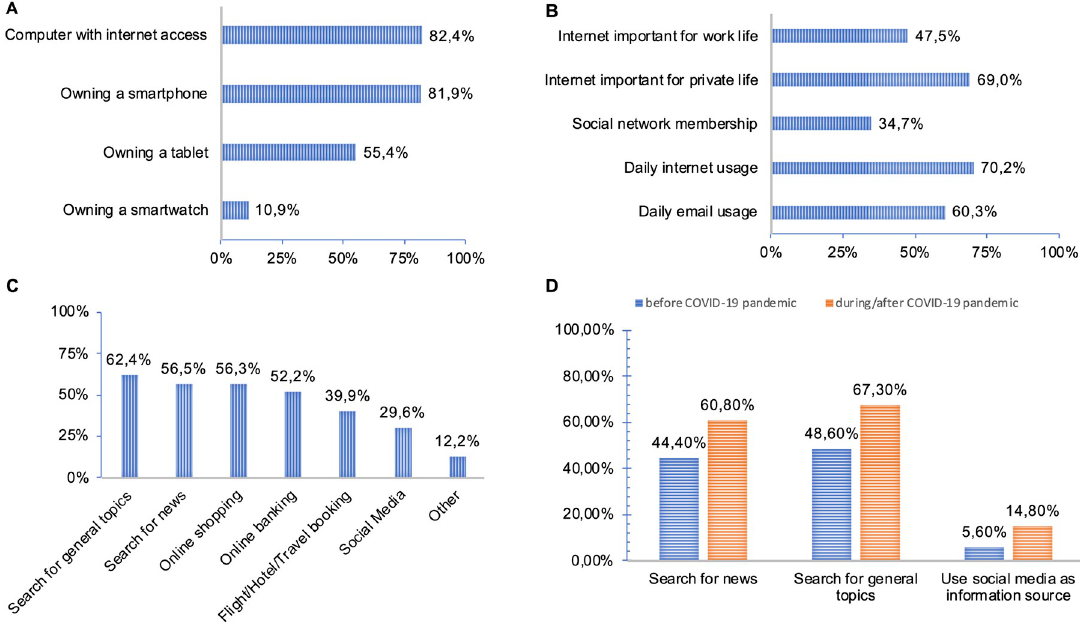
Fig 2. A. Dissemination of internet-enabled devices. B. Penetration and use of modern ICT in daily life. C. Non-health-related topics cancer patients search for online. D. Usage of Online Services and COVID-19